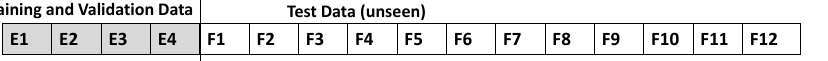
Figure 4. Experimental data. The training and validation data, E1–E4, are used to create a model. Prediction model is tested on completely unseen data, F1 through F12. ISPD 2016 placement contest benchmarks are used for